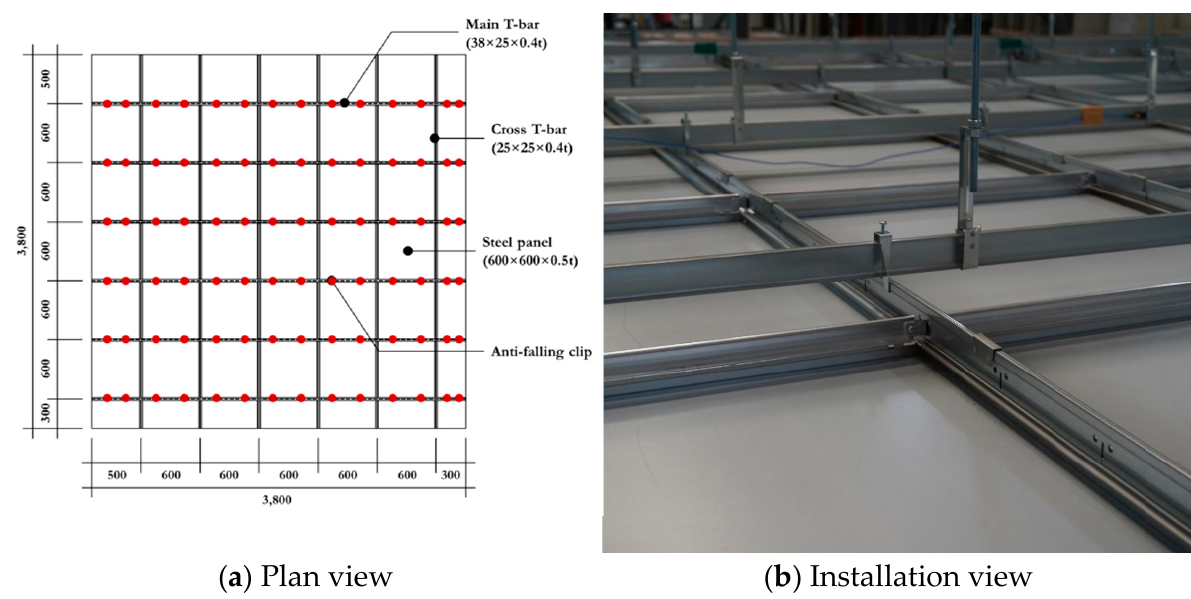
Figure 5. Main T-bar and the cross T-bar plan: ( a ) plan view of the specimen (main T-bar–cross T-bar), and the ( b ) installation view of the specimen.